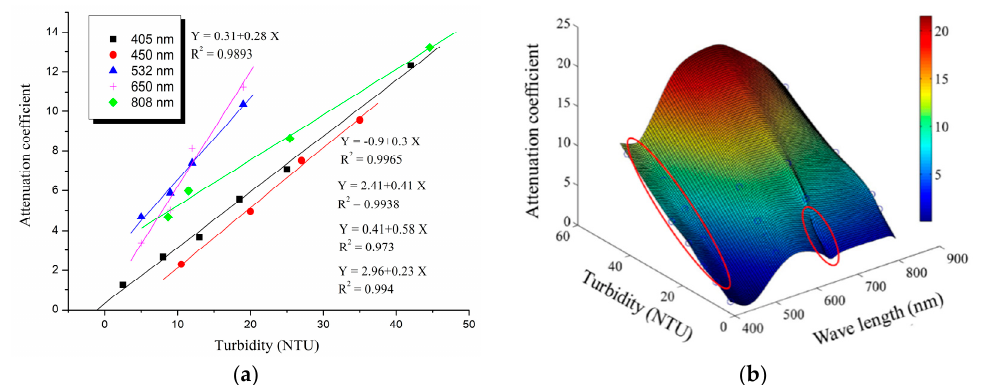
Figure 6. Attenuation coefficient—turbidity curve in dissolution medium of SiO 2 : ( a ) Two dimension; ( b ) Three dimension.